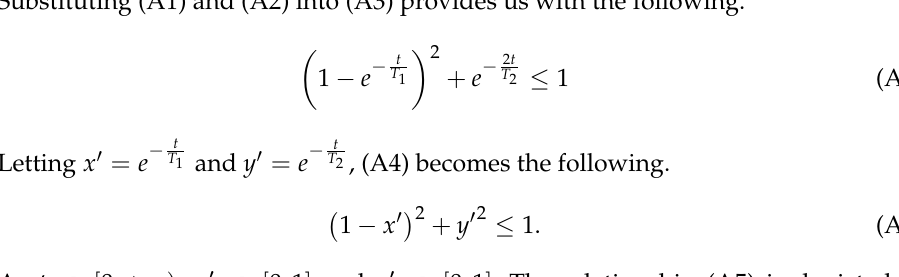
Figure A1. The area under the thick red curve represents all the x (cid:48) and y (cid:48) values sat- isfying (A5). In the blue shaded area, y (cid:48) ≤ x (cid:48) , i.e., e